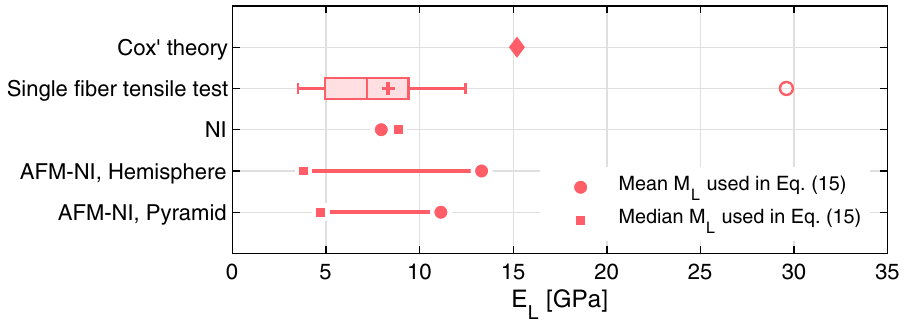
Figure 6. Estimates of the longitudinal modulus E L of the fibers from nanoindentation experiments (AFM-NI and NI) compared to the E L values obtained by single fiber tensile testing and Cox’ theory. The box plot for the single fiber tensile test consists of median (line in box), mean (cross in box), interquartile range IQR (box), whisker length 1.5·IQR, and outliers (open